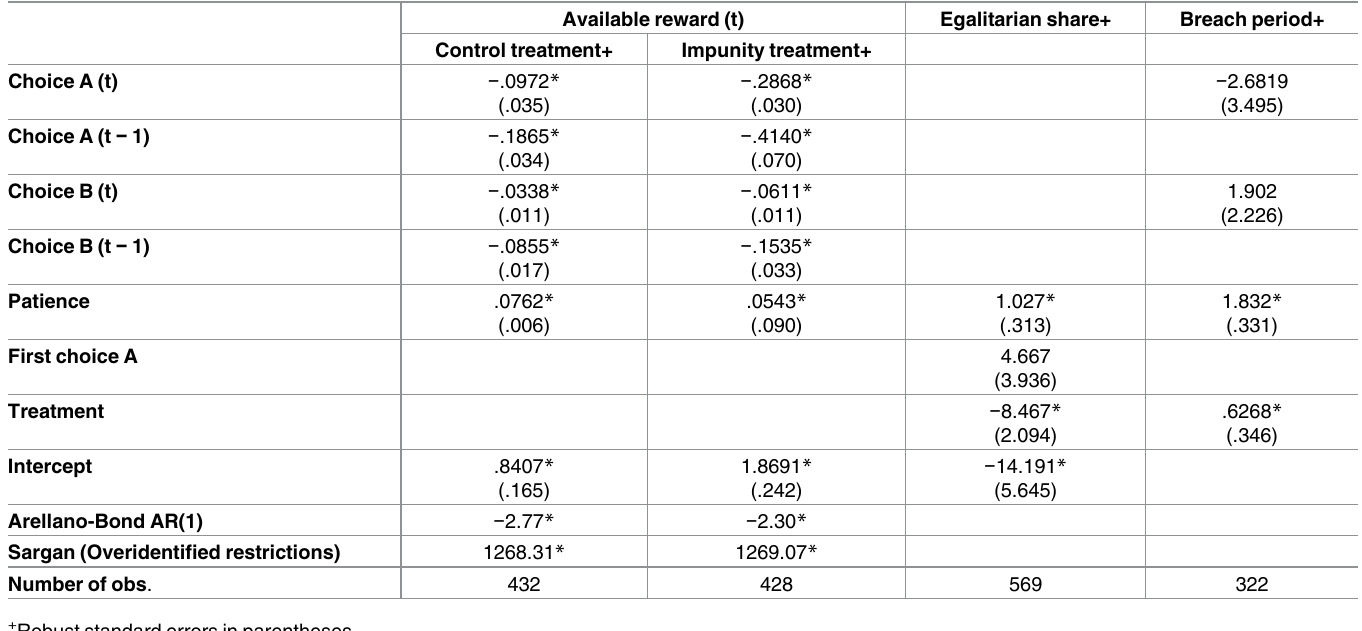
Table 2. Regressions on the determinants of holding available the reward, getting an egalitarian profit distribution and the breach